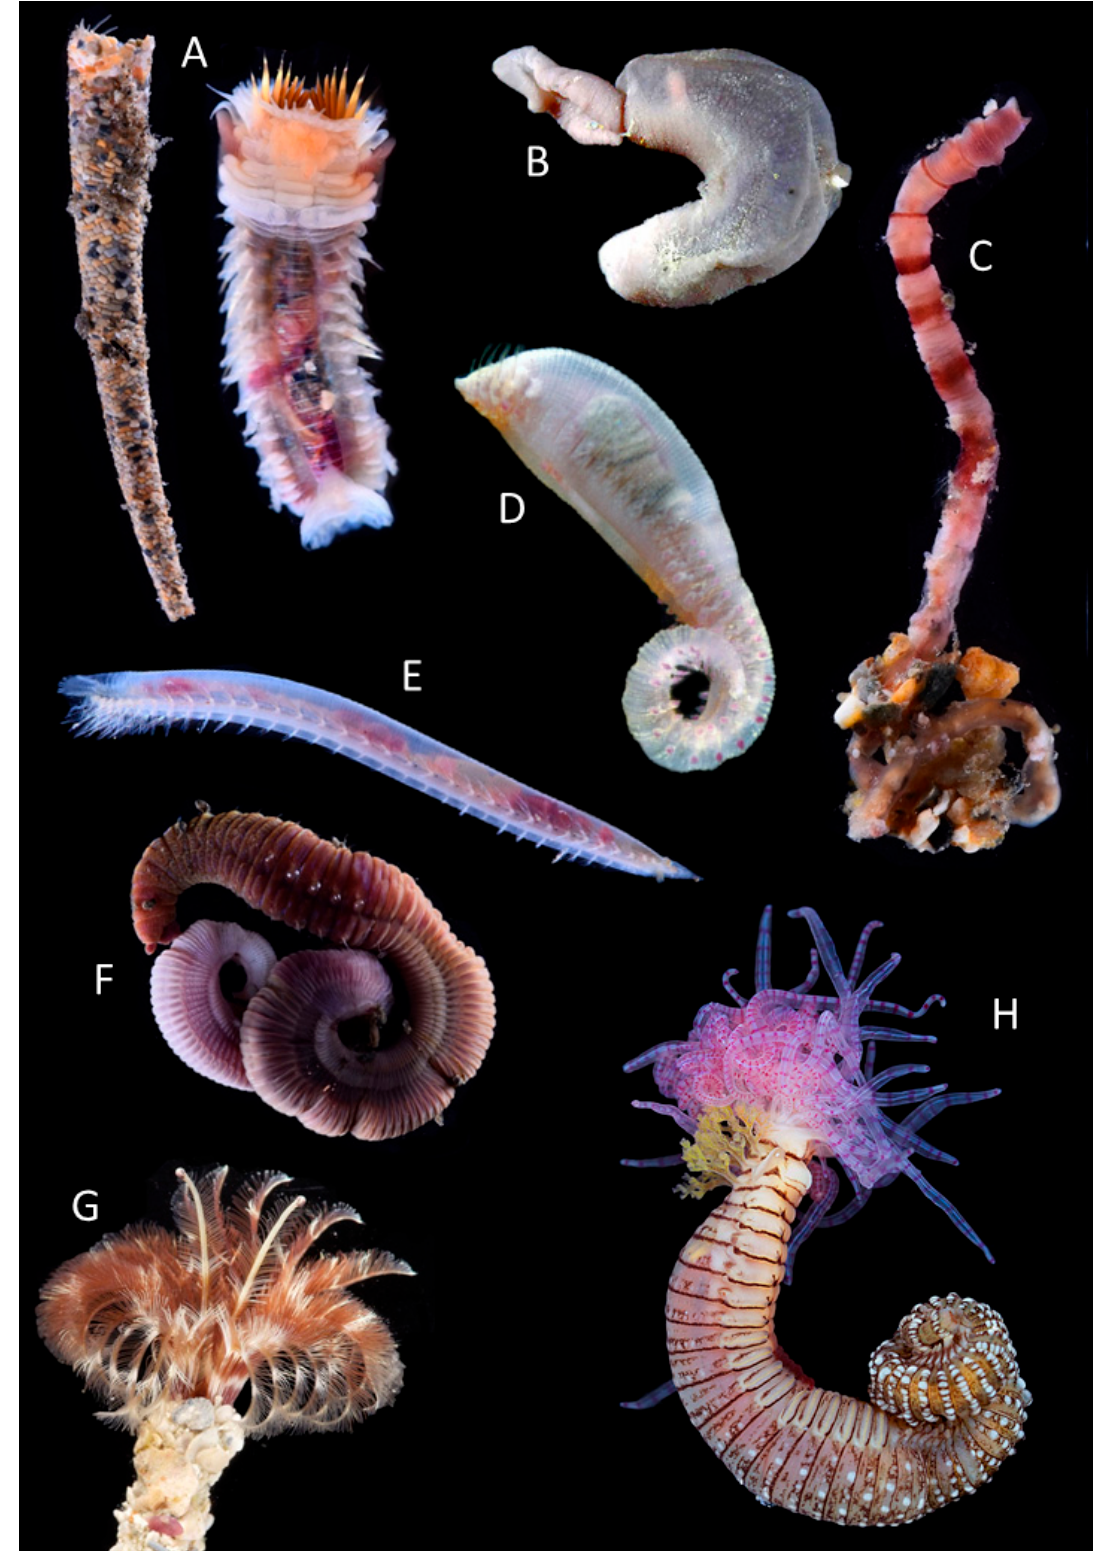
Figure 2. Small selection of the diversity encountered in Sedentaria. ( A ). Amphictene auricoma (O.F. Müller, 1776) (Terebe- lliformia); ( B ). Maxmuelleria gigas (M. Müller, 1852) (Echiura); ( C ). Maldanidae (Capitellida); ( D ). Escalibregma sp. (Scali- bregmatidae); ( E ). Armandia polyophthalma Kükenthal, 1887 (Opheliida), ( F ). Dasybranchus gajolae Eisig, 1887 (Capitellida); ( G ). Acromegalomma sp. (Sabellida); ( H ). Loimia tuberculata Nogueira, Hutchings & Carrerette, 2015 (Terebelliformia). Photos: ( A , C , E , F ) by Xavier Salvador Costa; ( D ) by Dani Martin, ( G , H ) by Alexander Semenov.